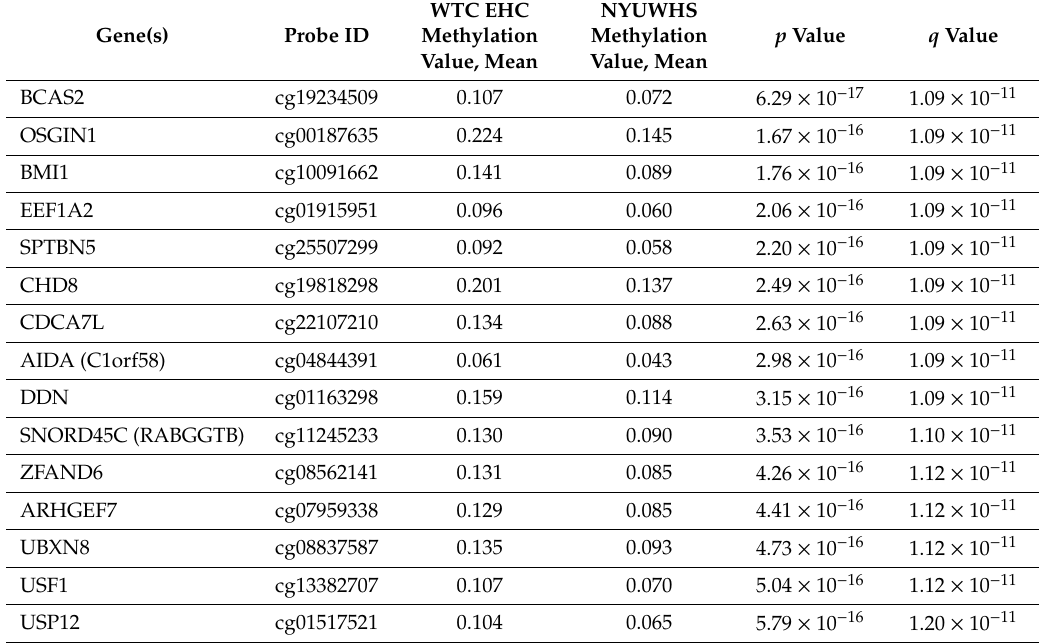
Table 2. Top 15 di ff erentially methylated probes of the WTC-exposed (WTC EHC) vs. unexposed (NYUWHS) cancer-free